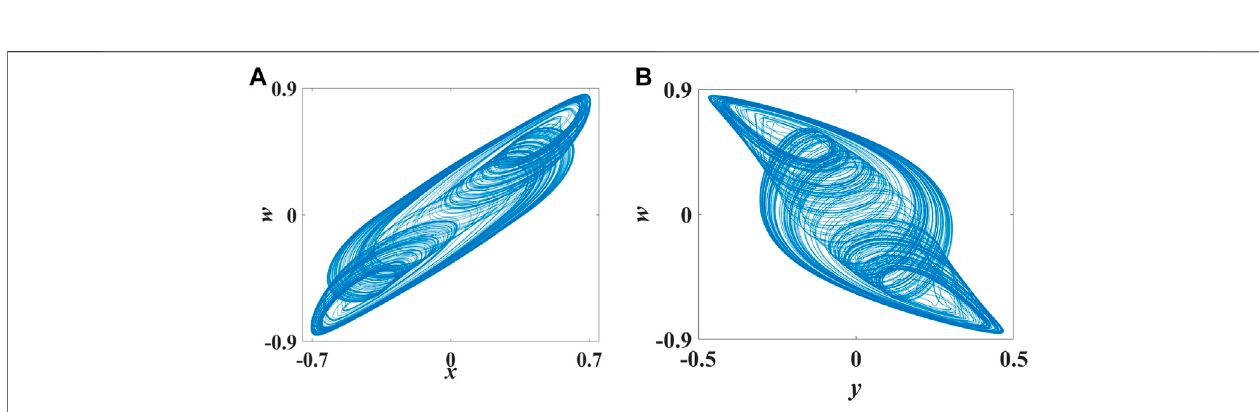
FIGURE 1 | Eq. 1 sets the parameters as a (cid:1) 3 . 5 , b (cid:1) 0 . 5 , c (cid:1) 2 . 5 , d (cid:1) 0 . 7 , e (cid:1) 3 . 4 , f (cid:1) 1 . 6 , g (cid:1) 0 . 95 , h (cid:1) 2 . 5 , m (cid:1) 1 . 9 , n (cid:1) 1 . 5 , α (cid:1) 0 . 24 , β (cid:1) 0 . 7 and the initial condition is selected as ( 0 . 1 , 0 . 1 , 0 . 1 , 0 . 1 ) . (A) is the spectrum of Lyapunov exponent with parameter a ∈ ( 3 , 5 ) , (B) is the spectrum of Lyapunov exponent with